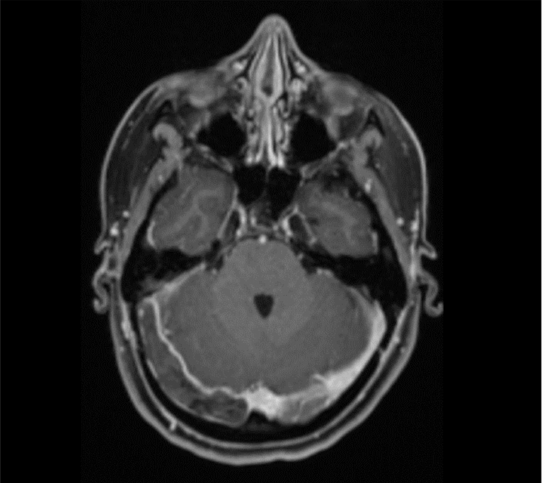
Figure 1. Thrombosis of the right sinus transverse and sigmoid sinus in a 29-year-old woman who presented with headache, nausea and left-sided hemiparesis. Risk factors for cerebral venous sinus thrombosis were obesity (BMI 30.5 kg/m 2 ) and oral contraception. She was diagnosed with non-VITT